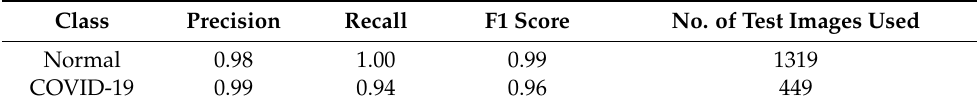
Table 2. Model evaluation on different metrices before using cGAN.